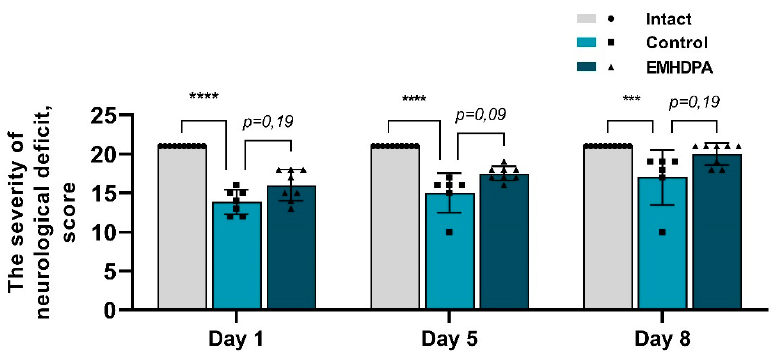
Figure 3. Dynamics of the severity of neurological injuries in the studied groups on the scale of assessment of the severity of neurological deficit in meningitis, meningoencephalitis (by the average score in the group). Note: ***— p < 0.001; ****— p < 0.0001; 1—intact group; 2—control group; 3—group administered with EMHDPA 25 mg/kg.